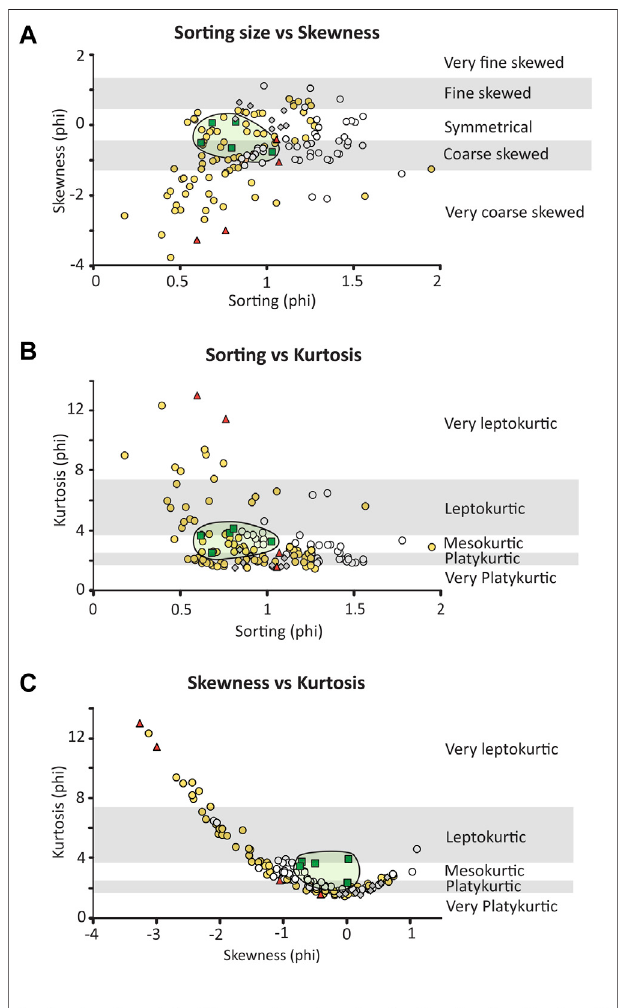
FIGURE 11 | Plot of sorting vs. (A) skewness and (B) kurtosis, and (C) the plot of skewness vs. kurtosis (which seems likely to help differentiate beachsand fromcandidatestorm deposits more thantheothertwoplotsand was statistically signi fi cant). Green color polygon indicated beach